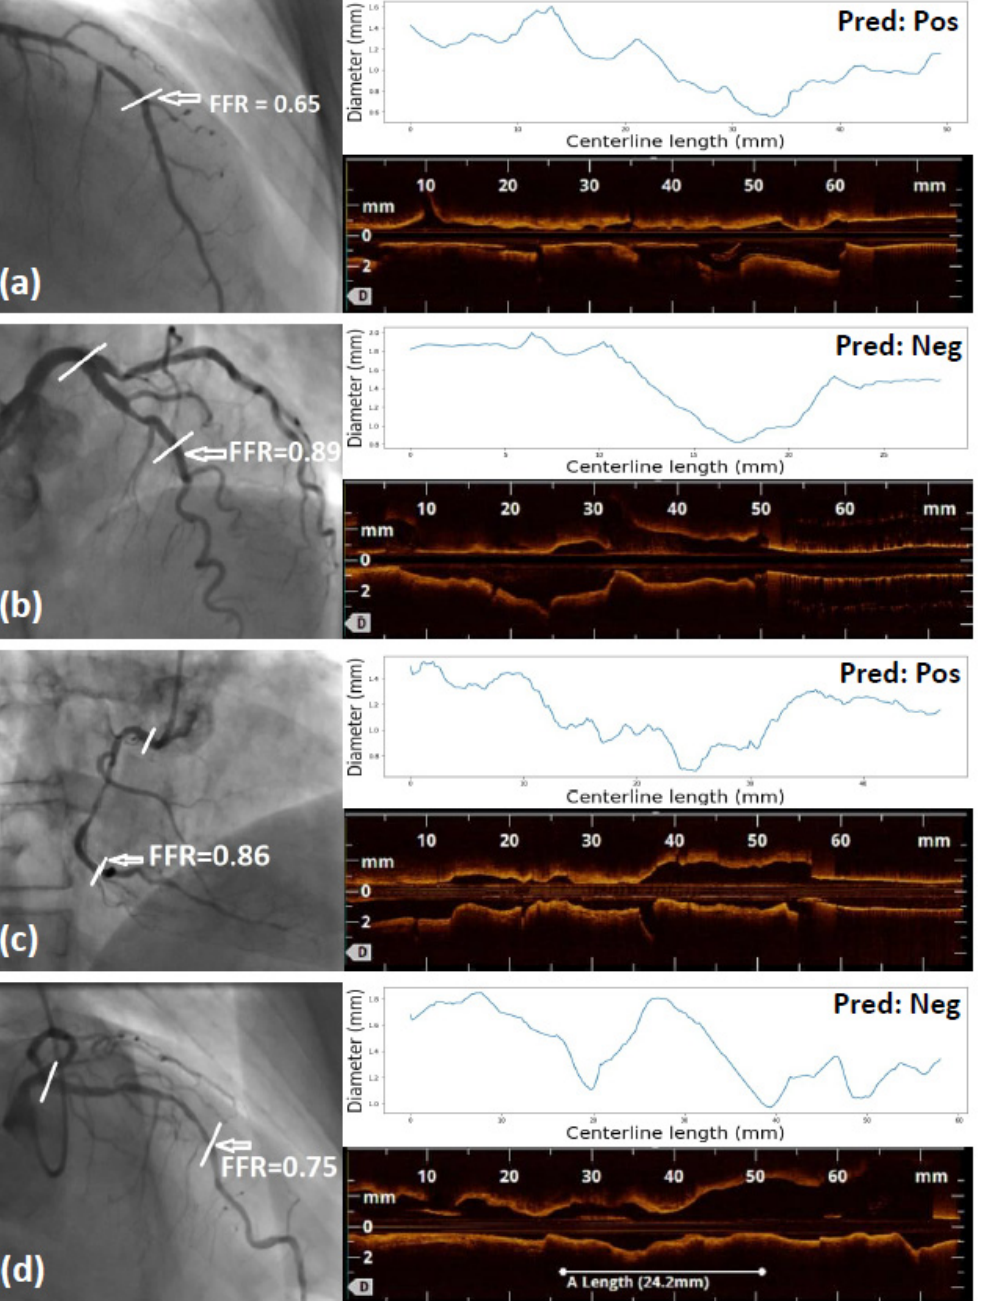
Figure 3. Four sample cases: one for each of the categories: ( a ) TP, ( b ) TN, ( c ) FP, and ( d ) FN. A representative angiographic frame is displayed indicating the invasive FFR value and the coronary vessel and region of interest visualized using OCT. The longitudinal OCT view and the radius profile used as input to the DNNs are also displayed.